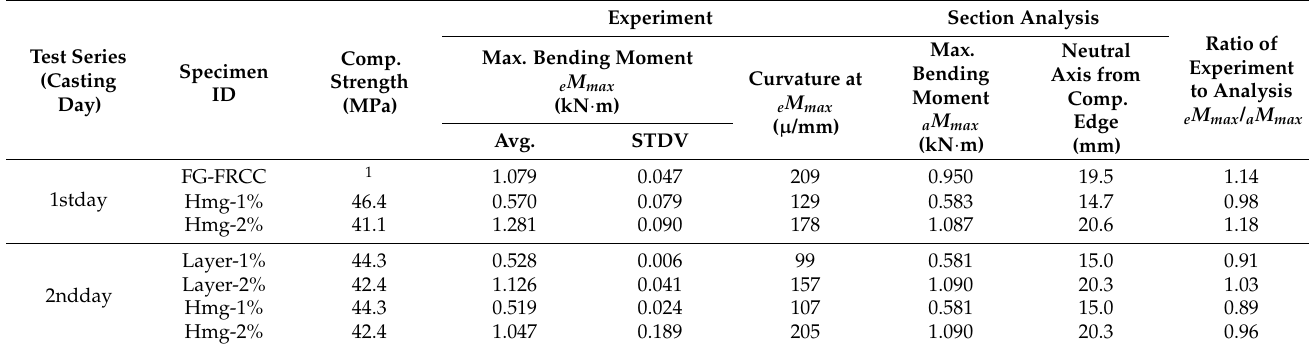
Table 4. List of maximum bending moment.